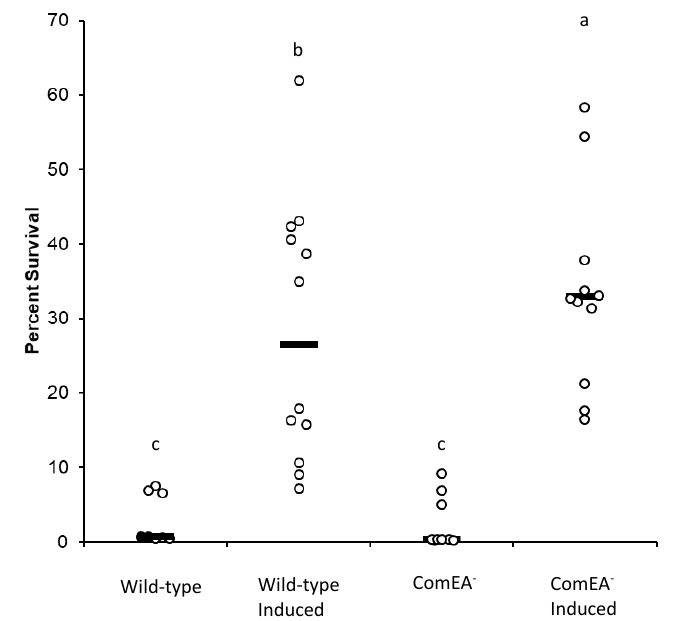
Figure 3. Cell survival following two-hour exposure to 5 mM t -BHP. Percent cell survival in the wild-type strain (HAM501) and ComEA − (AAK502) strains either treated with 0 or 1 mM IPTG following treatment with 5 mM t -BHP. At least nine replicates were completed for each condition. Lower case letters were used to denote significant di ff erences between means. “a”, “b”, and “c” are significantly di ff erent mean groups.